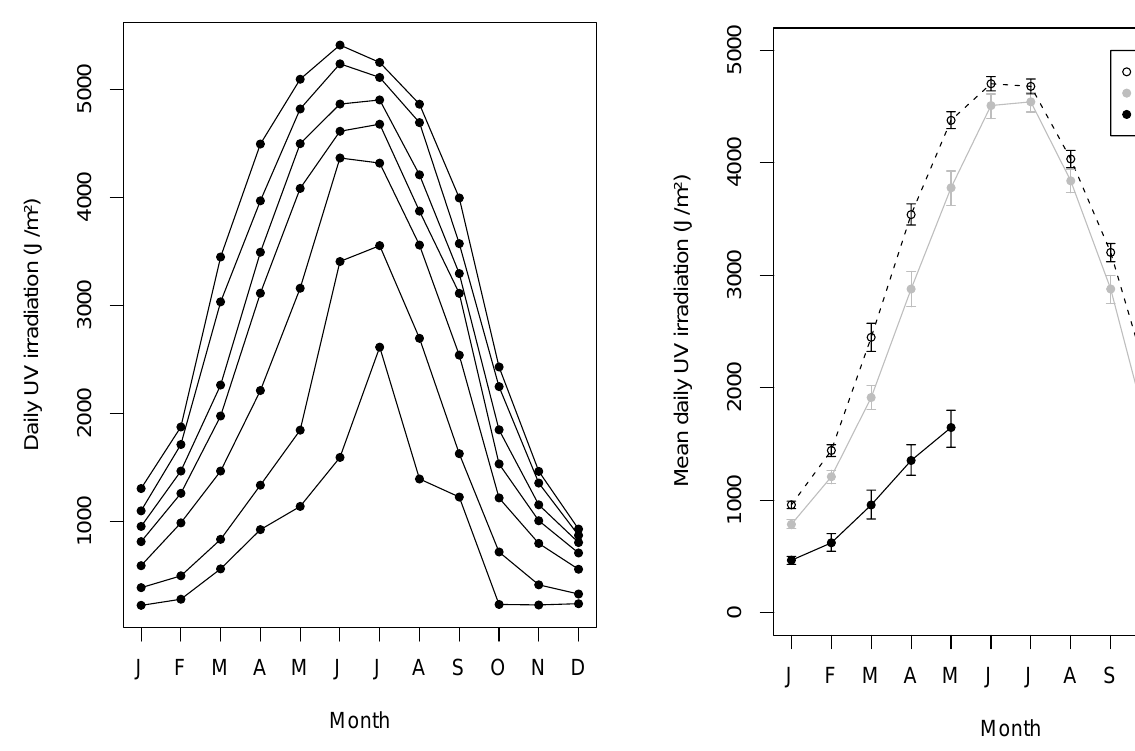
Fig. 4. Annual evolution of the mean of daily ultraviolet erythemal